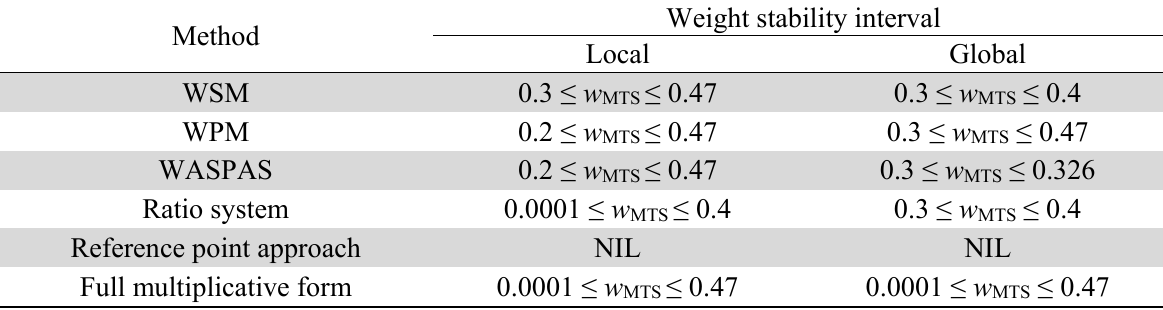
Fig. 2. Results of single dimensional weight sensitivity analysis for Example 1 Single dimensional weight stability intervals for Example